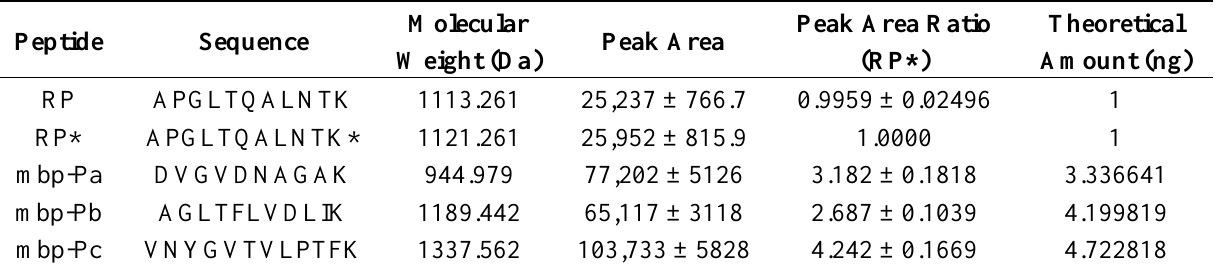
Table 2. Quantification of unlabeled reference peptide (RP), labeled reference peptide (RP*) and maltose-binding protein (mbp) unique peptides.